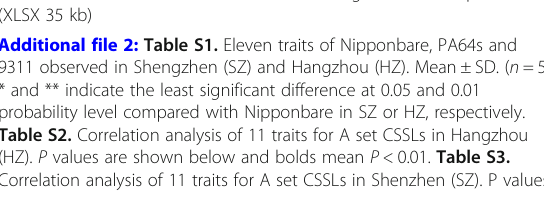
Table S2. Correlation analysis of 11 traits for A set CSSLs in Hangzhou (HZ). P values are shown below and bolds mean P < 0.01. Table S3. Correlation analysis of 11 traits for A set CSSLs in Shenzhen (SZ). P